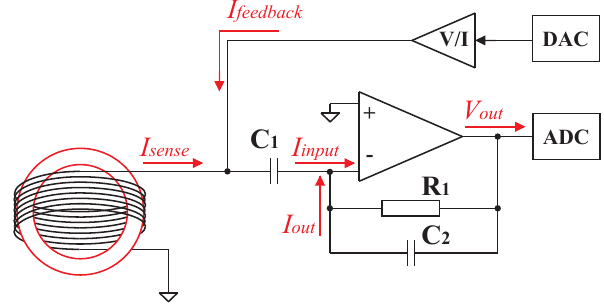
Fig. 5. Equivalent circuit of the sensor preamplifier in the prototype instrument.